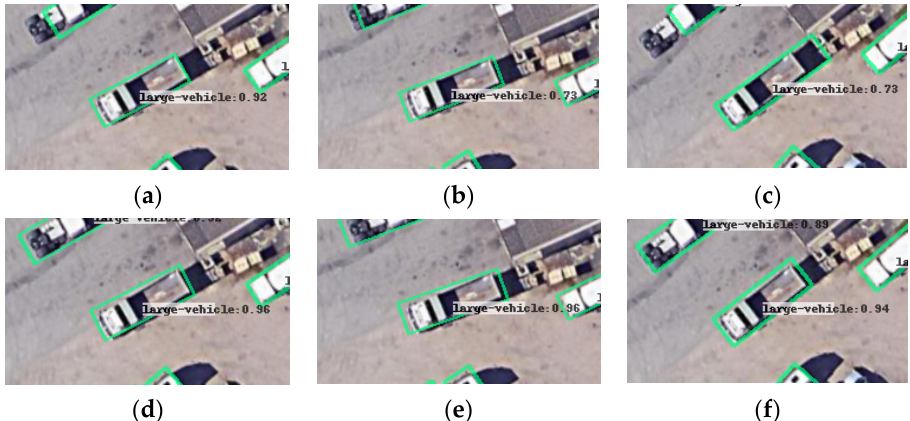
Figure 4. The auxiliary anchor method can improve the non-anchor angle target score. ( a ) The baseline score when the target and anchor angle is same. ( b , c ) The baseline score when the target and anchor angle is different, which shows the decrease in score is 0.19, caused by the angle increase. ( d ) Our method score when the target and anchor angle is the same. ( e , f ) Our method score when the target and anchor angle is different in our method, which shows the decrease in score is 0.02, caused by the angle increase. It can be found that this method can effectively improve the score of the target when the angle of the target is different from that of the anchor.